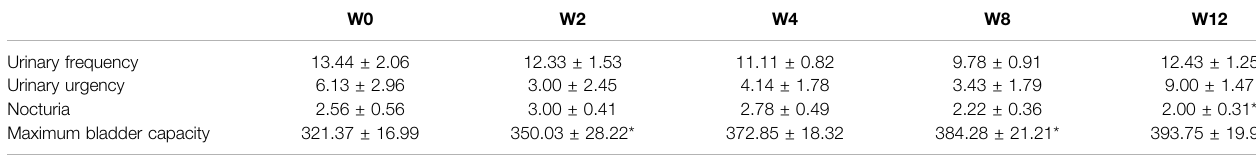
TABLE 2 | Urinary voiding symptom score of patients with interstitial cystitis/bladder pain syndrome according to bladder diary during 12 weeks of dextrose prolotherapy.